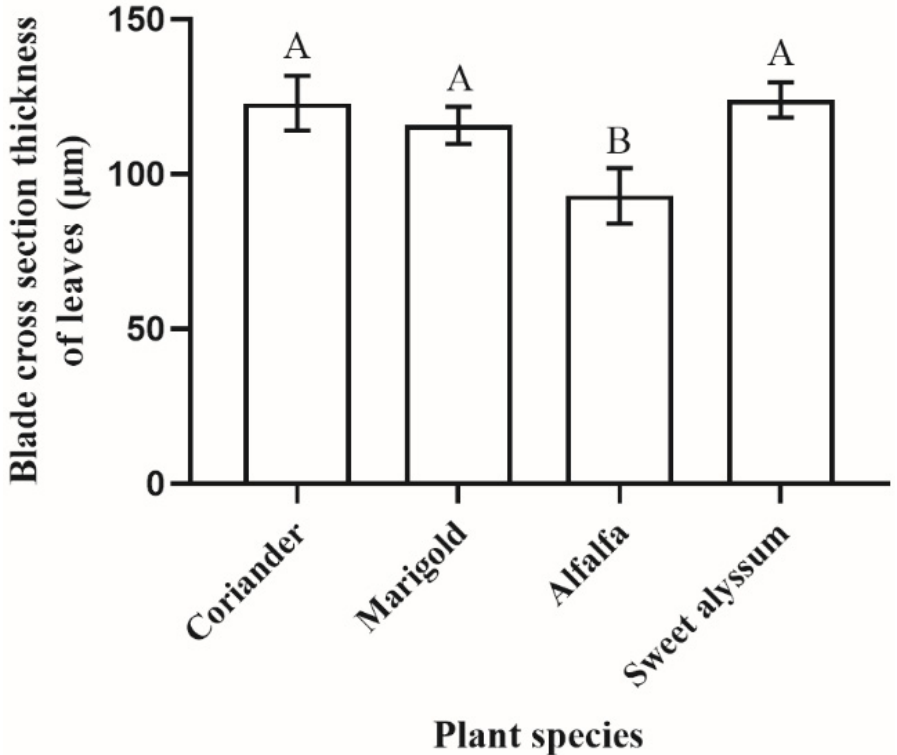
Figure 8. A comparison of the thickness of leaf-blade cross-sections among different plant species ( n = 5–7), indicating significant differences ( α = 0.05; ANOVA). Values are mean ± SE. Means indicated by the same letter are not significantly different according to LSD test.